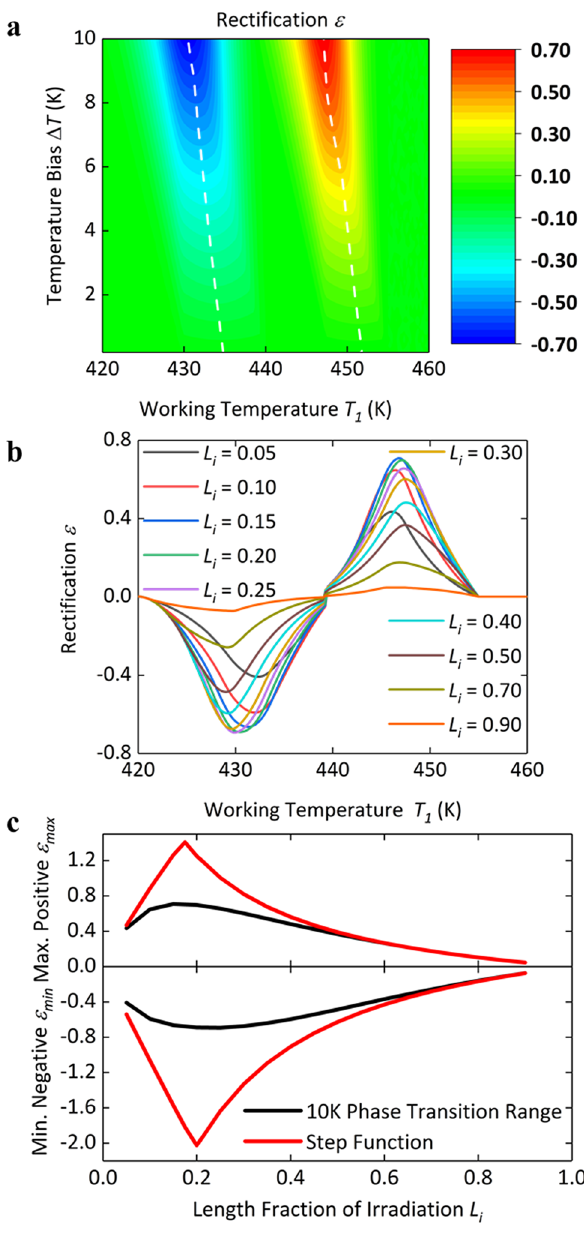
Figure 5. Rectification performance and optimization study of the LI-P junction. ( a ) Rectification performance of the LI-P junction as a function of working temperature T 1 and temperature bias Δ T. The length fraction of irradiation is 20%. The white dashed lines mark the local maximum positive rectification ε max_local and local minimum negative rectification ε min_local at a certain temperature bias Δ T , respectively. ( b ) Rectification as a function of working temperature T 1 with different length fractions of irradiation. ( c ) Maximum positive rectification ε max and minimum negative rectification ε min as a function of length fraction with finite temperature ranges of phase transition for both the segments, 10 K for the LI segment and 7.5 K for the pristine segment, and the step function phase transitions for both the segments,